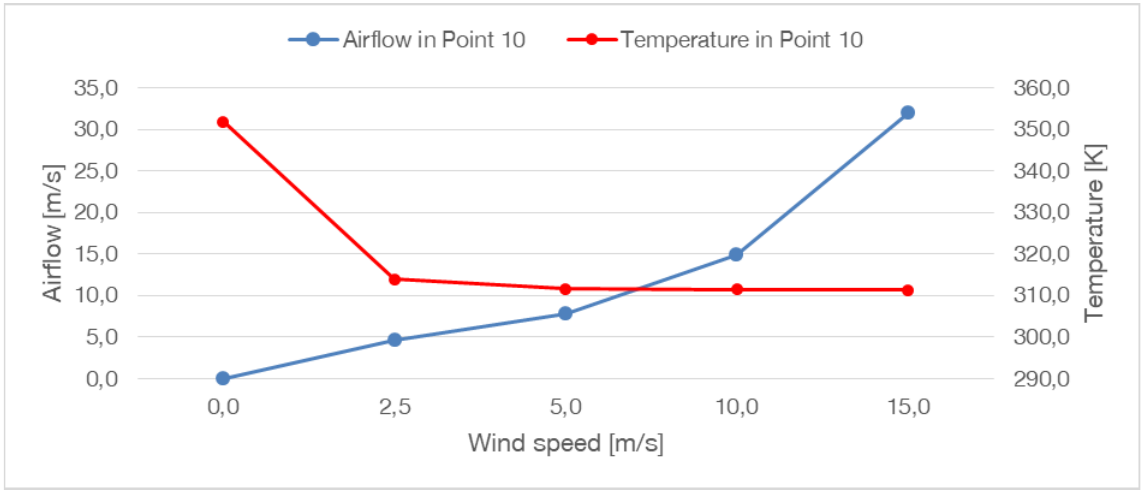
Figure 9: Compilation of temperature and air velocity for the ventilated facade with closed joints at Point 10.